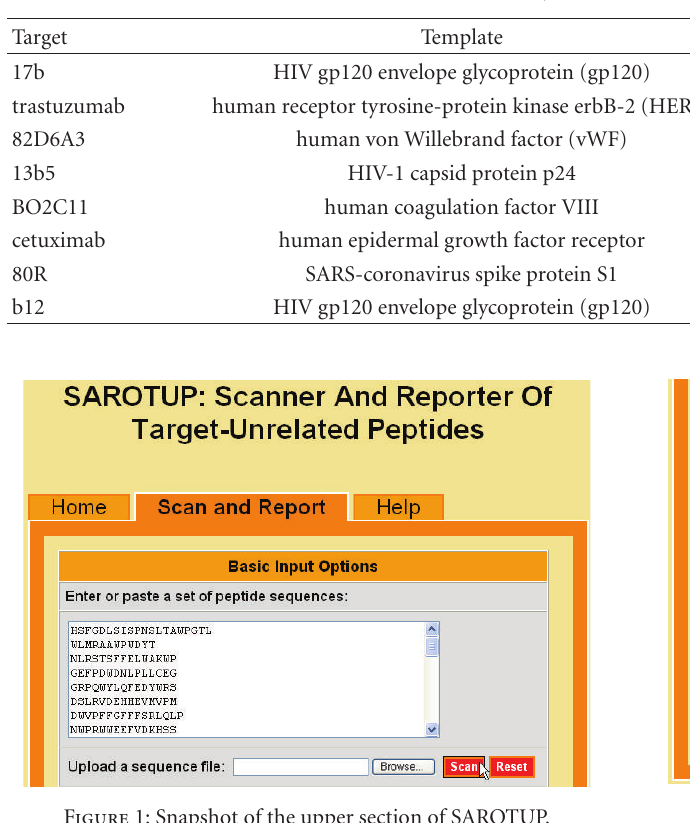
Table 2: A summary of the first test data set for SAROTUP.